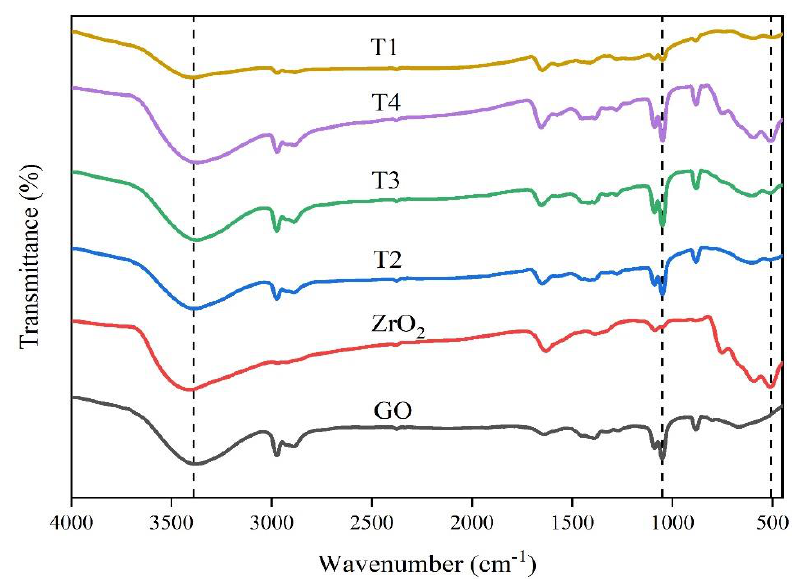
Figure 4. FT-IR spectra of GO, ZrO 2 , and ZrO 2 /RGO composite T1–T4. Raman analysis is a very important mean to characterize the sp 3 and sp 2 hybridized carbon atoms in graphene [28]. As shown in Figure 5, under the excitation at the wavelength of 532 nm, the composites showed two characteristic peaks at 1593 cm − 1 and 1335 cm − 1 , which corresponded to the G and D bands of graphene, respectively. The D-band was related to the defect state of graphene, and the G-band came from the in-plane vibration of carbon atoms in graphene [29]. The intensity ratios of D to G for GO and composites T1–T4 were 0.76, 0.83, 0.850, 0.853, and 0.86, respectively. The intensity of D-band/the intensity of G-band (I D /I G ) of the composites increased, indicating that the surface defects of the composites increased with the increase of ZrO 2 concentration.